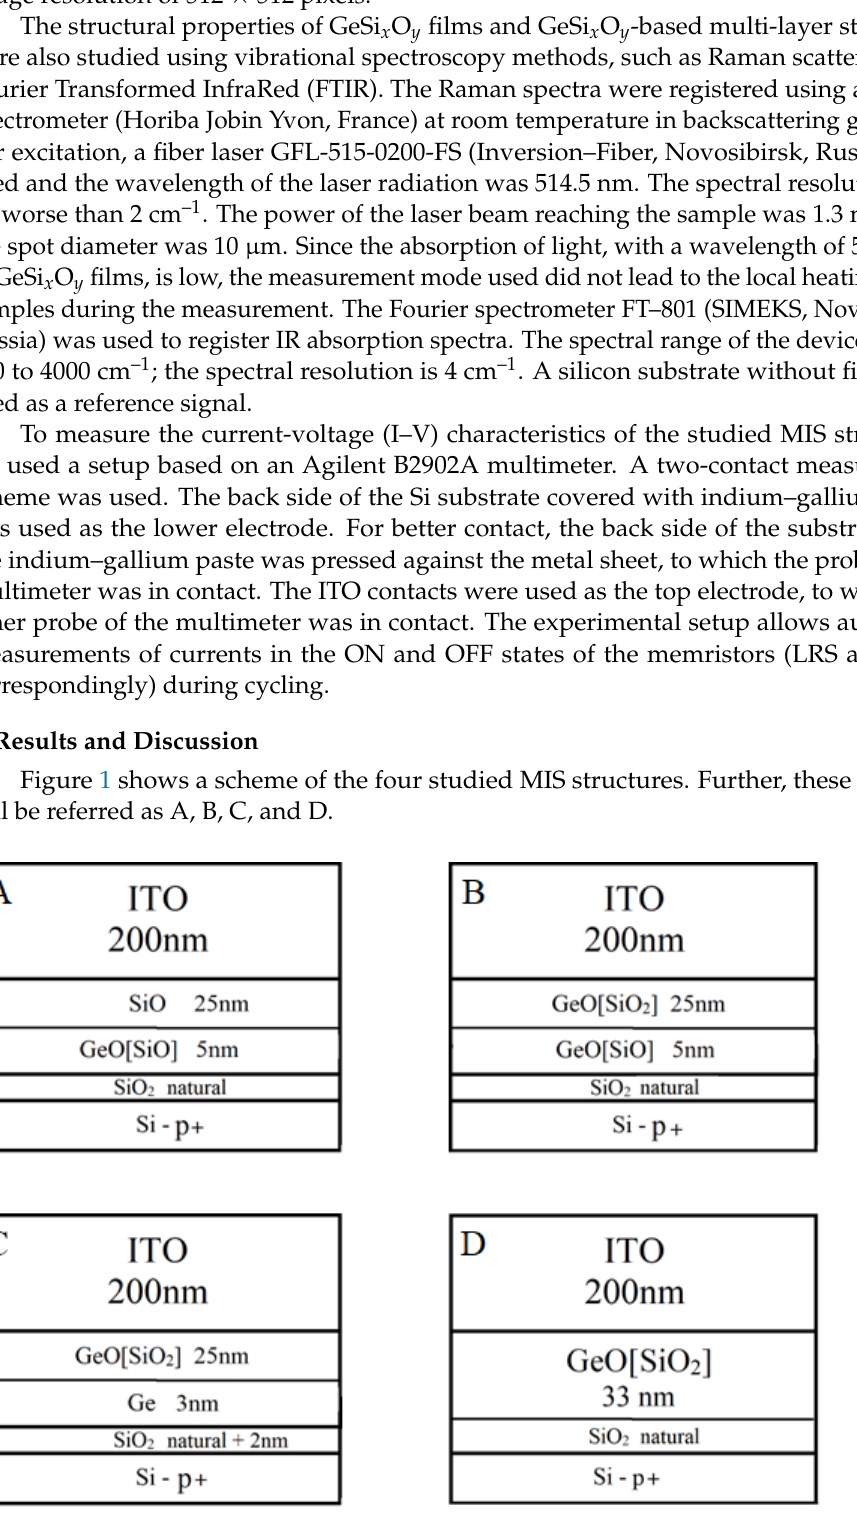
Figure 1. Scheme of MIS samples of structures ( A – D ).